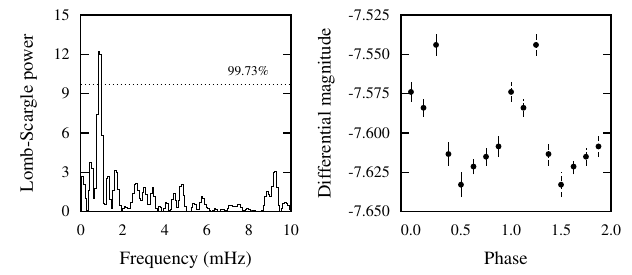
Figure 3: SHOC periodogram and light curve folded on the detected period of 1168 ± 214 s (obtained on 15 April